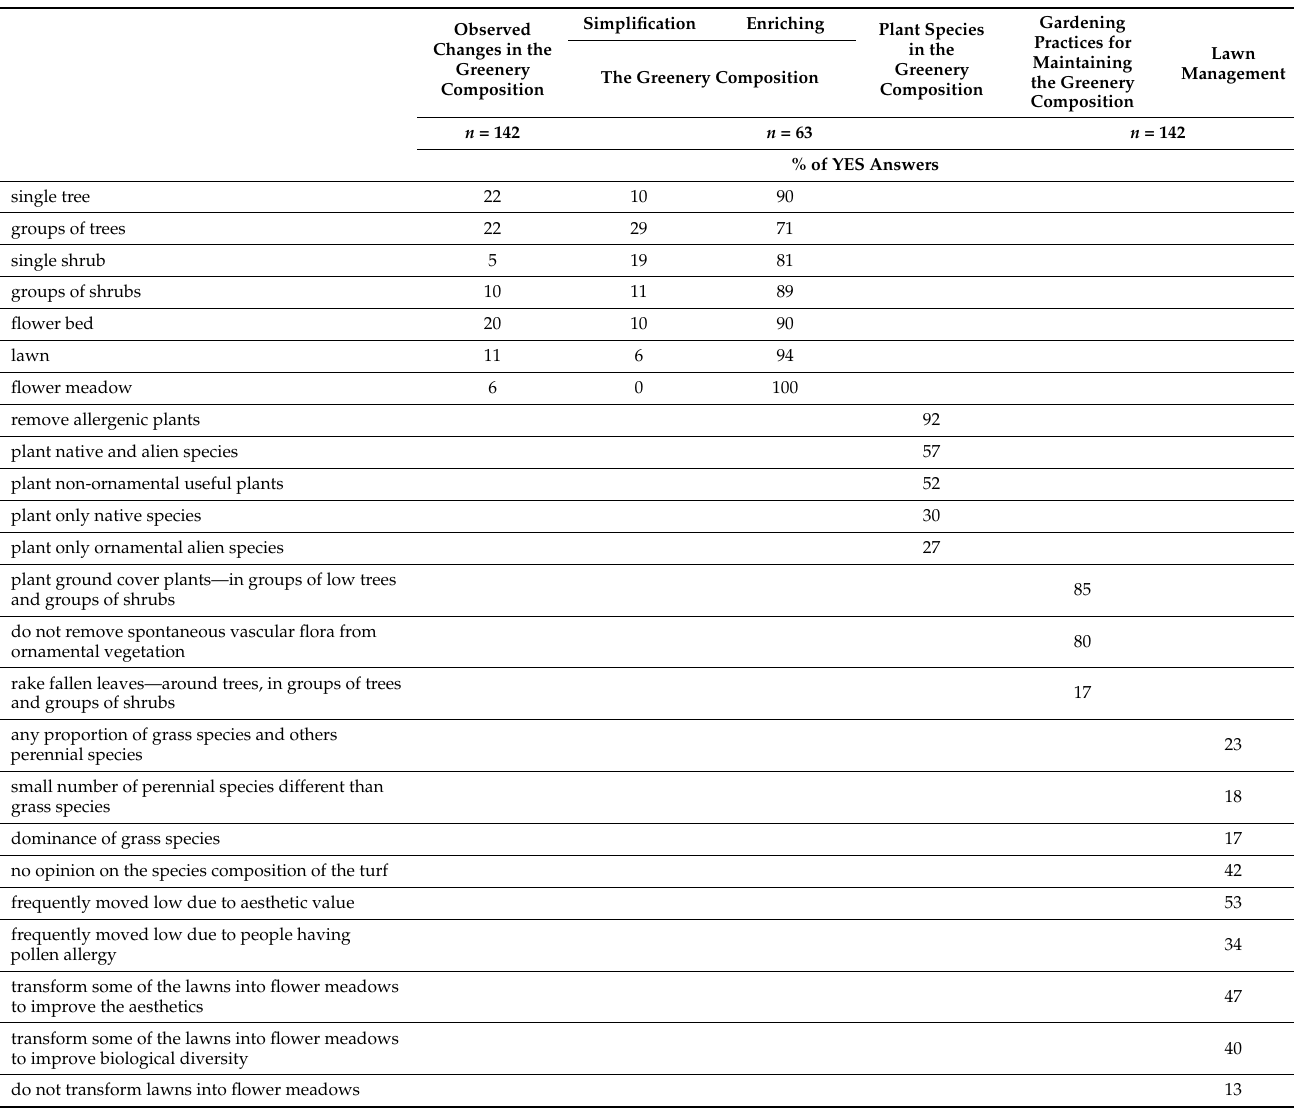
Table A2. The perception towards elements of the proposed vegetation cover pattern and gardening practices maintaining its